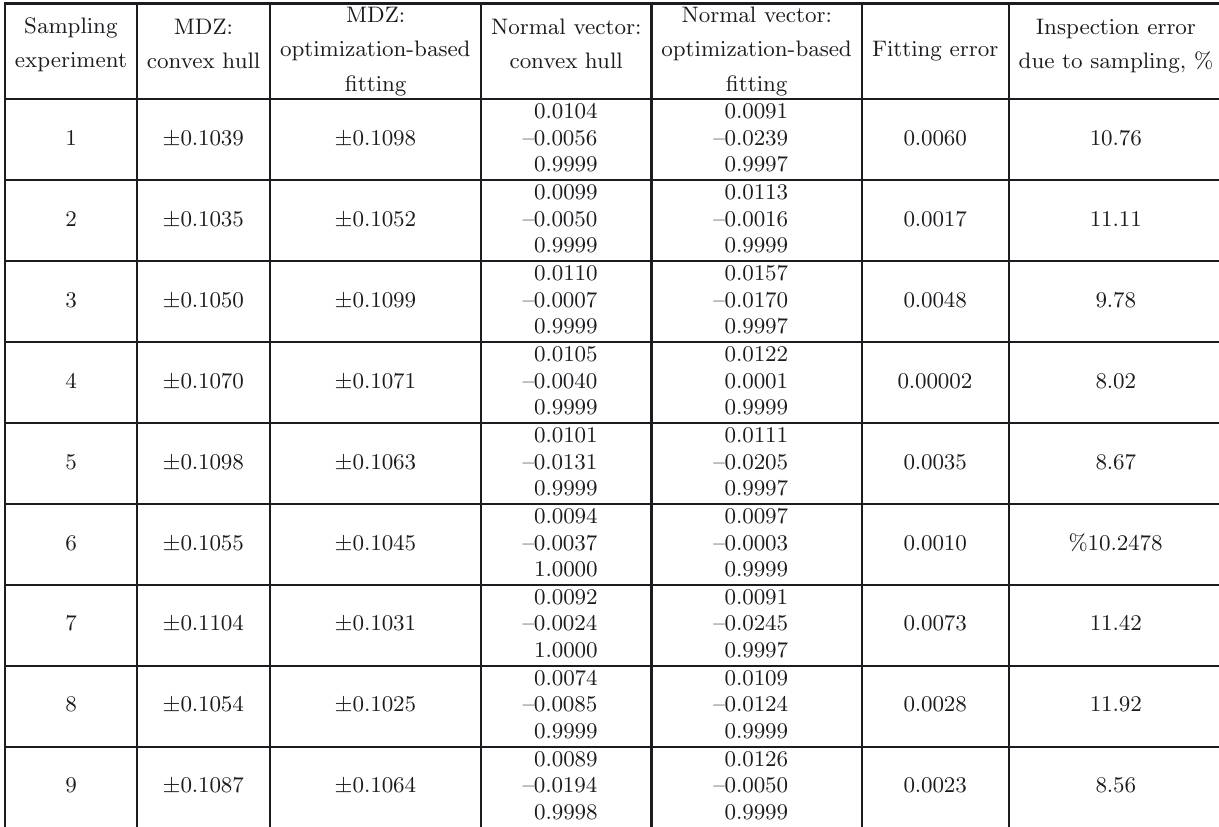
Table 2. MDZs, normal vectors, fitting uncertainties, inspection errors due to sampling of 9 random sampling experiments with sample sizes of 200 data points-Units in columns 2, 3, 6 and 7 are in millimetres.